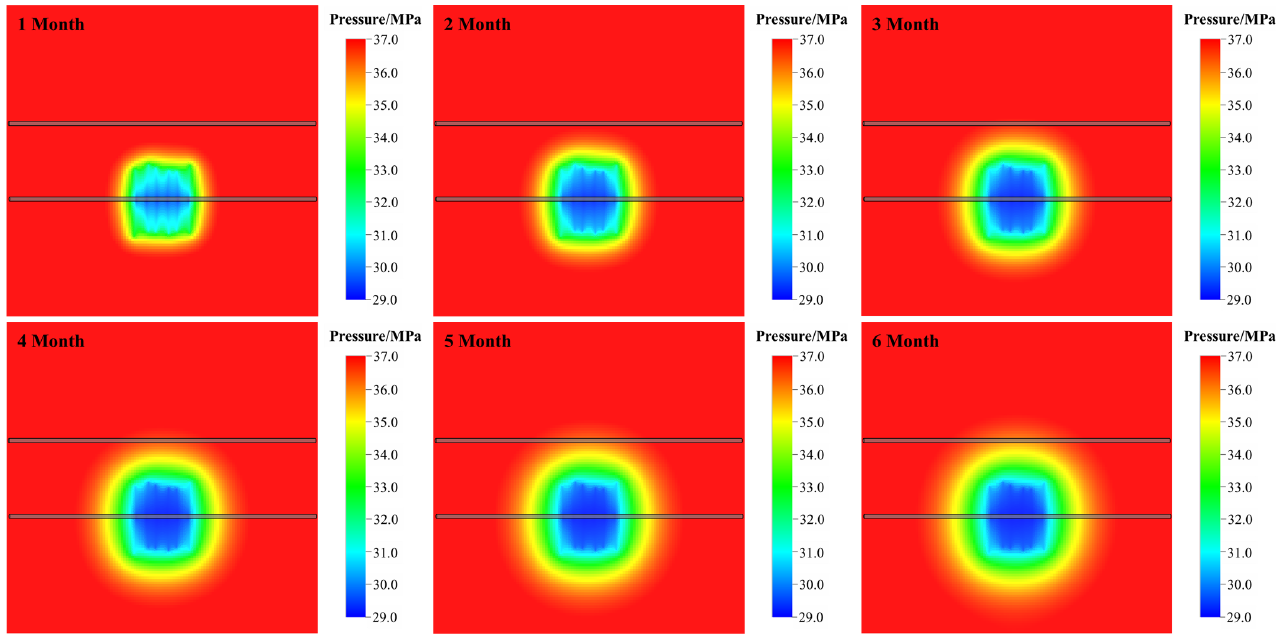
Figure 10. ( a ) Unstructured grid of the fractured reservoir model; ( b ) Production cumulative profile of the passive well.